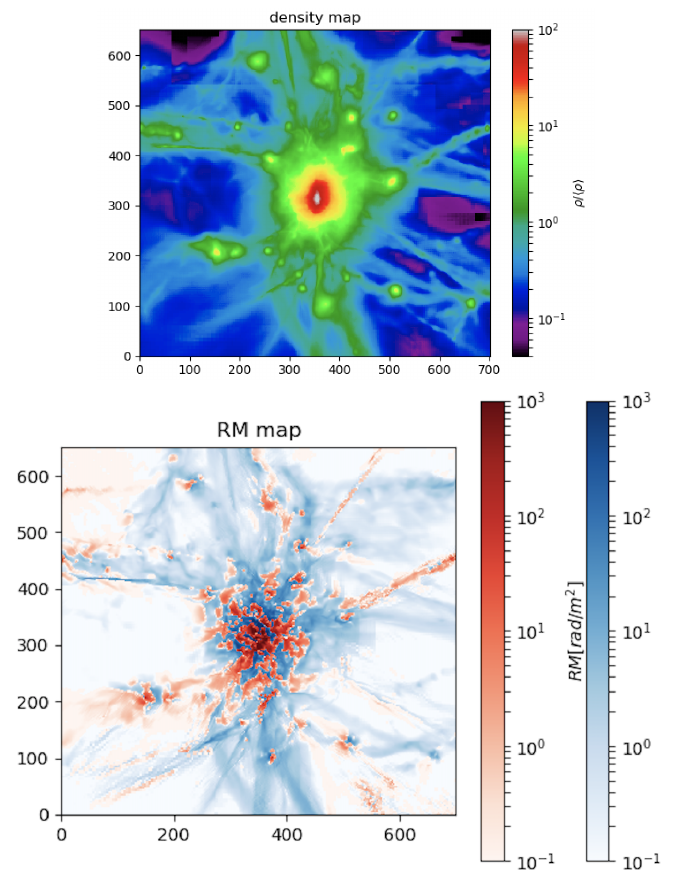
Figure 1. Projected gas density ( upper ) and RM ( lower ) for our cluster e18b at z = 0, for the non-radiative run with primordial magnetic fields. Each box has sides 22 × 20 Mpc 2 . In the RM map, we show with red colors pixels with RM > 0 and with blue colors the pixels with RM <